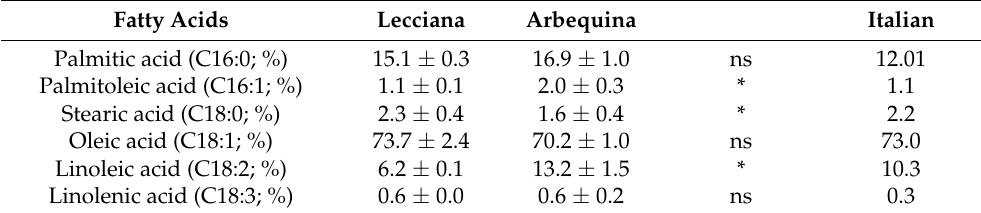
Table 7. Main fatty acids composition of ‘Lecciana’ oils compared to ’Arbequina’ ones. Mean values of 4 years ( ± SE ). * = statistical significance at p = 0.05 (Siegel-Tukey test); ns = not significant. Italian monovarietal EVOOs reference values are reported.